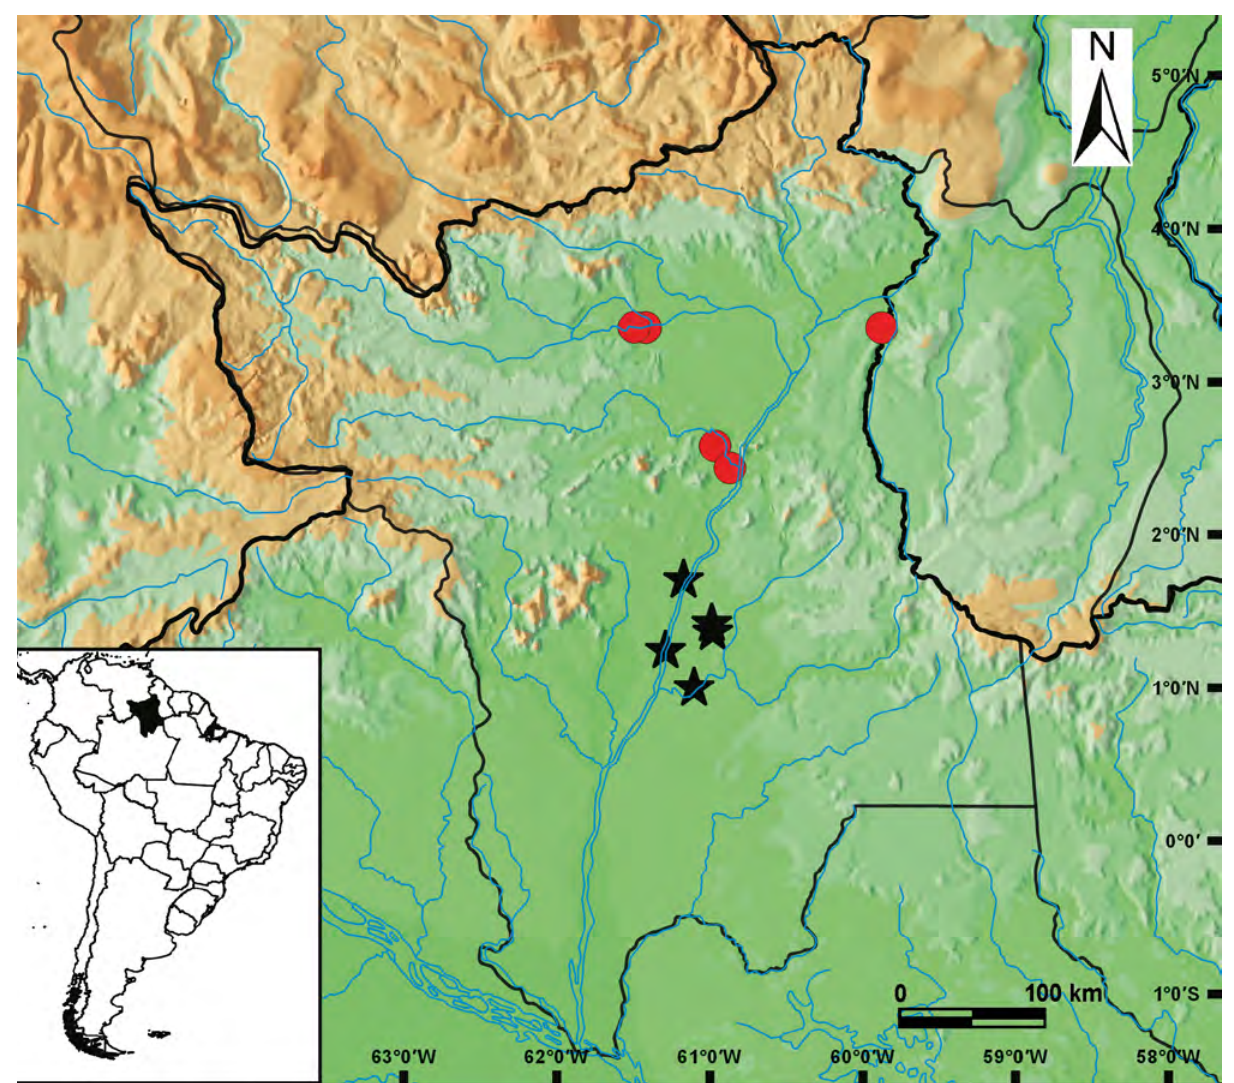
Figure 5. Distribution of the trichodactylid species, Moreirocarcinus laevifrons (Moreira, 1901) (star) and Poppiana dentata (Randall, 1840) (circle), in the state of Roraima,